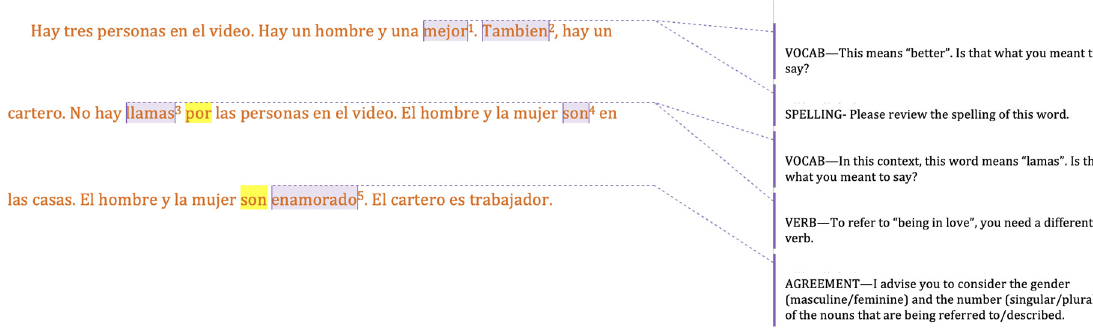
Figure 2. An example of the soundless YouTube video with personalized CF (codes + cues).